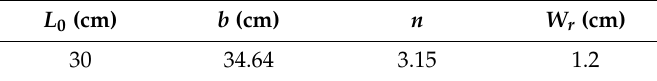
Table 6. The Parameters of the 30 cm